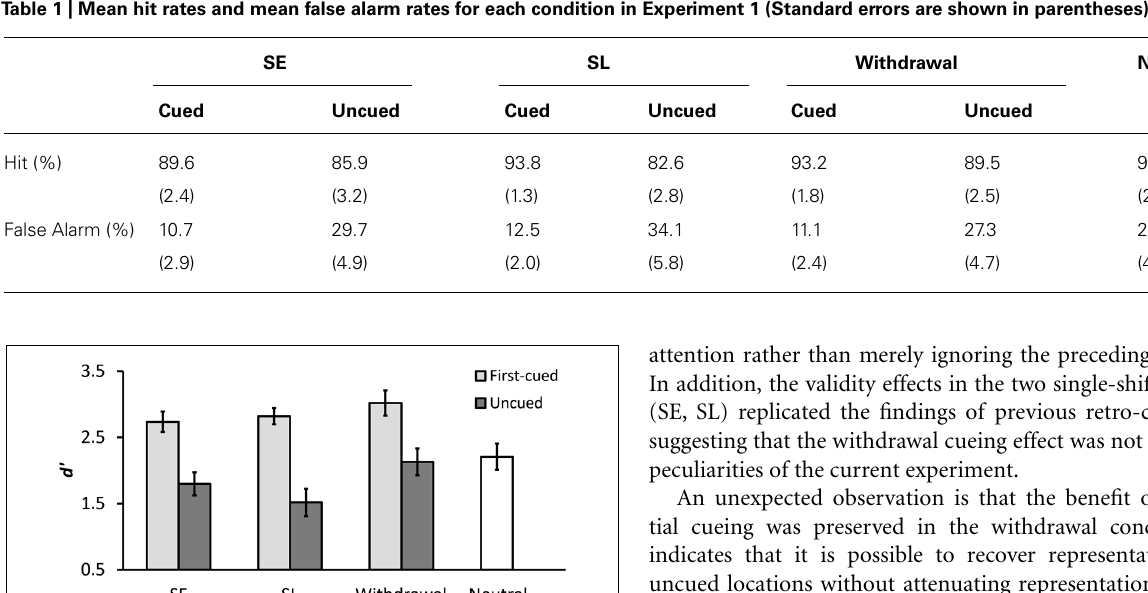
Table 1 | Mean hit rates and mean false alarm rates for each condition in Experiment 1 (Standard errors are shown in parentheses).